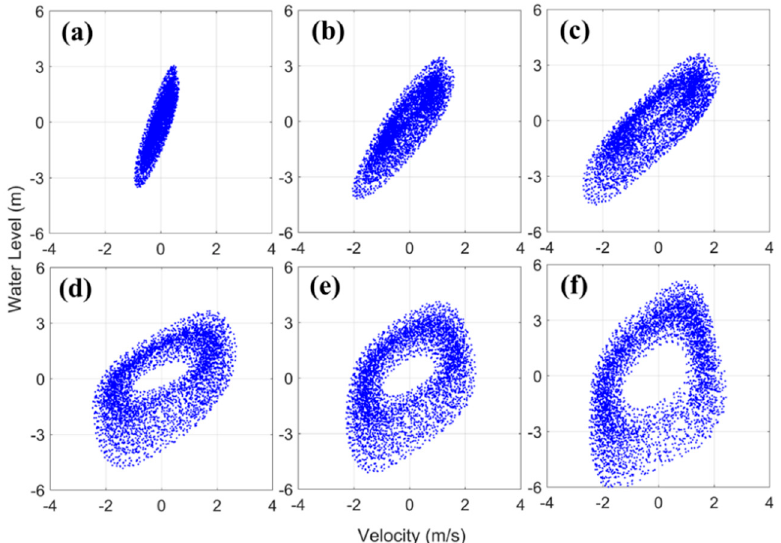
Figure 9. Tidal stage (water level vs. velocity) curves at six ADCP stations along the main axis of Cook Inlet showing the propagation of tidal wave in the system ( a ) COI0514; ( b ) COI0511; ( c ) COI0508; ( d ) COI0502; ( e ) COI1210; and ( f ) COI1209.